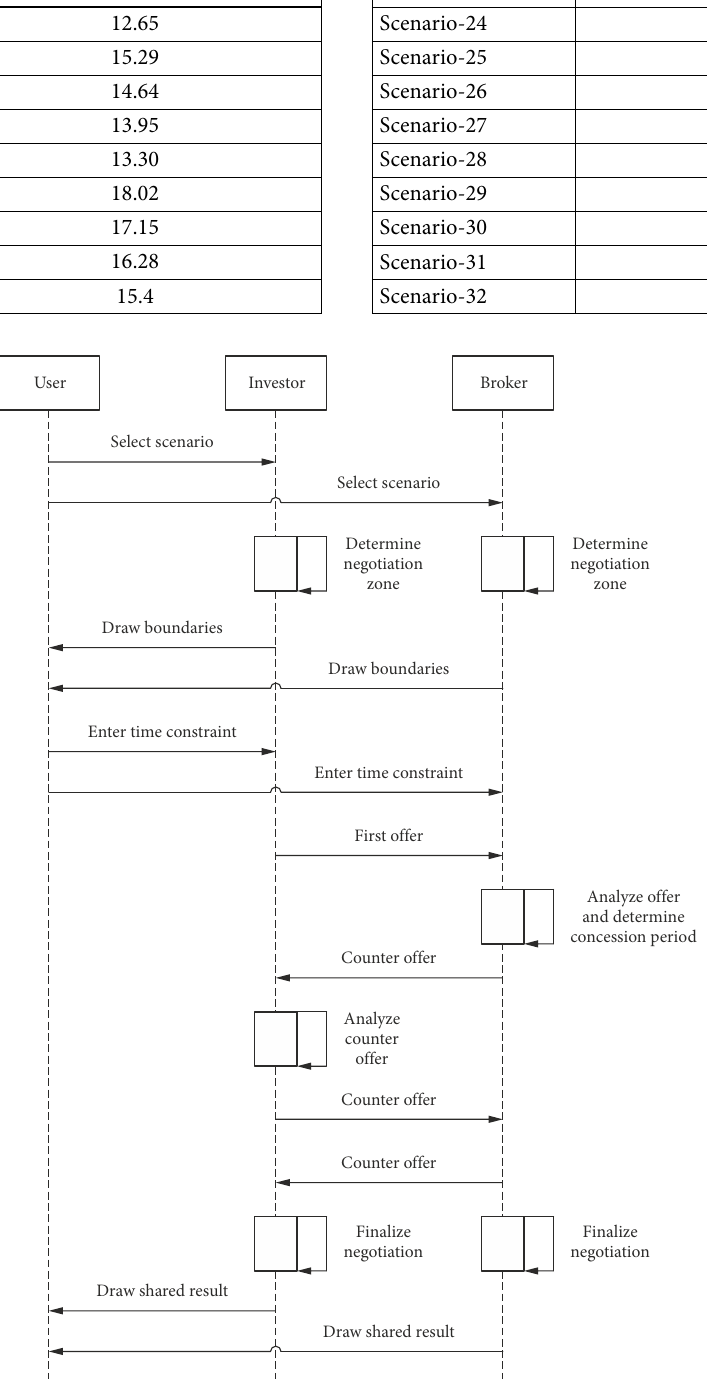
Figure 4. Sequence diagram for user and